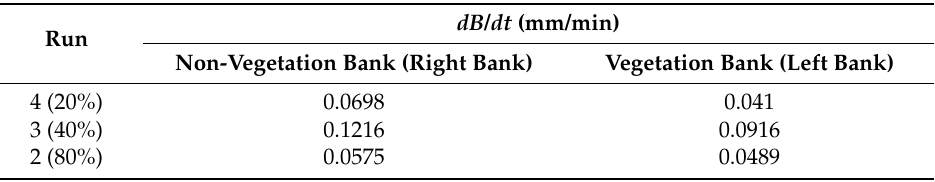
Table 4. Average channel bank widening rate of unilateral vegetation